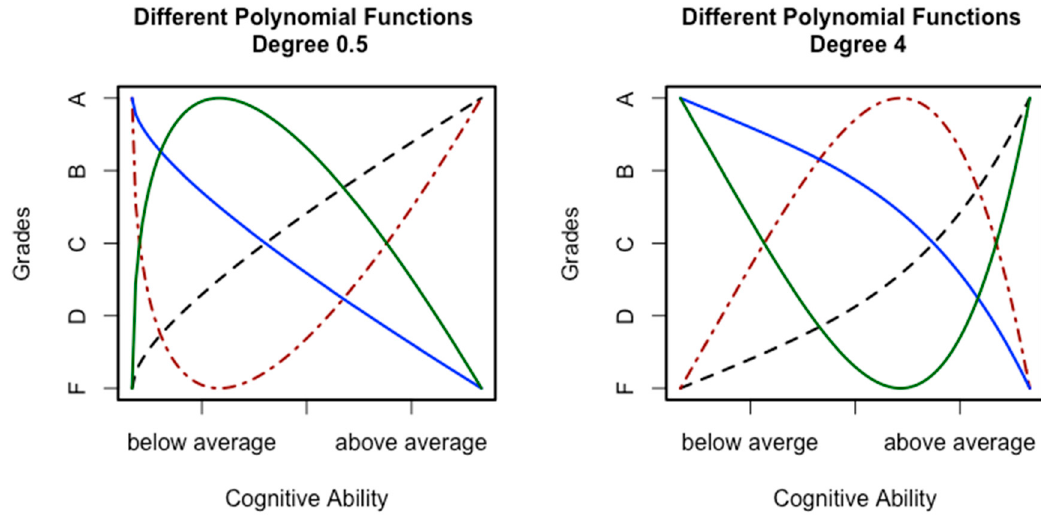
Figure 1. Hypothetical examples for curvilinear relations between cognitive ability and scholastic